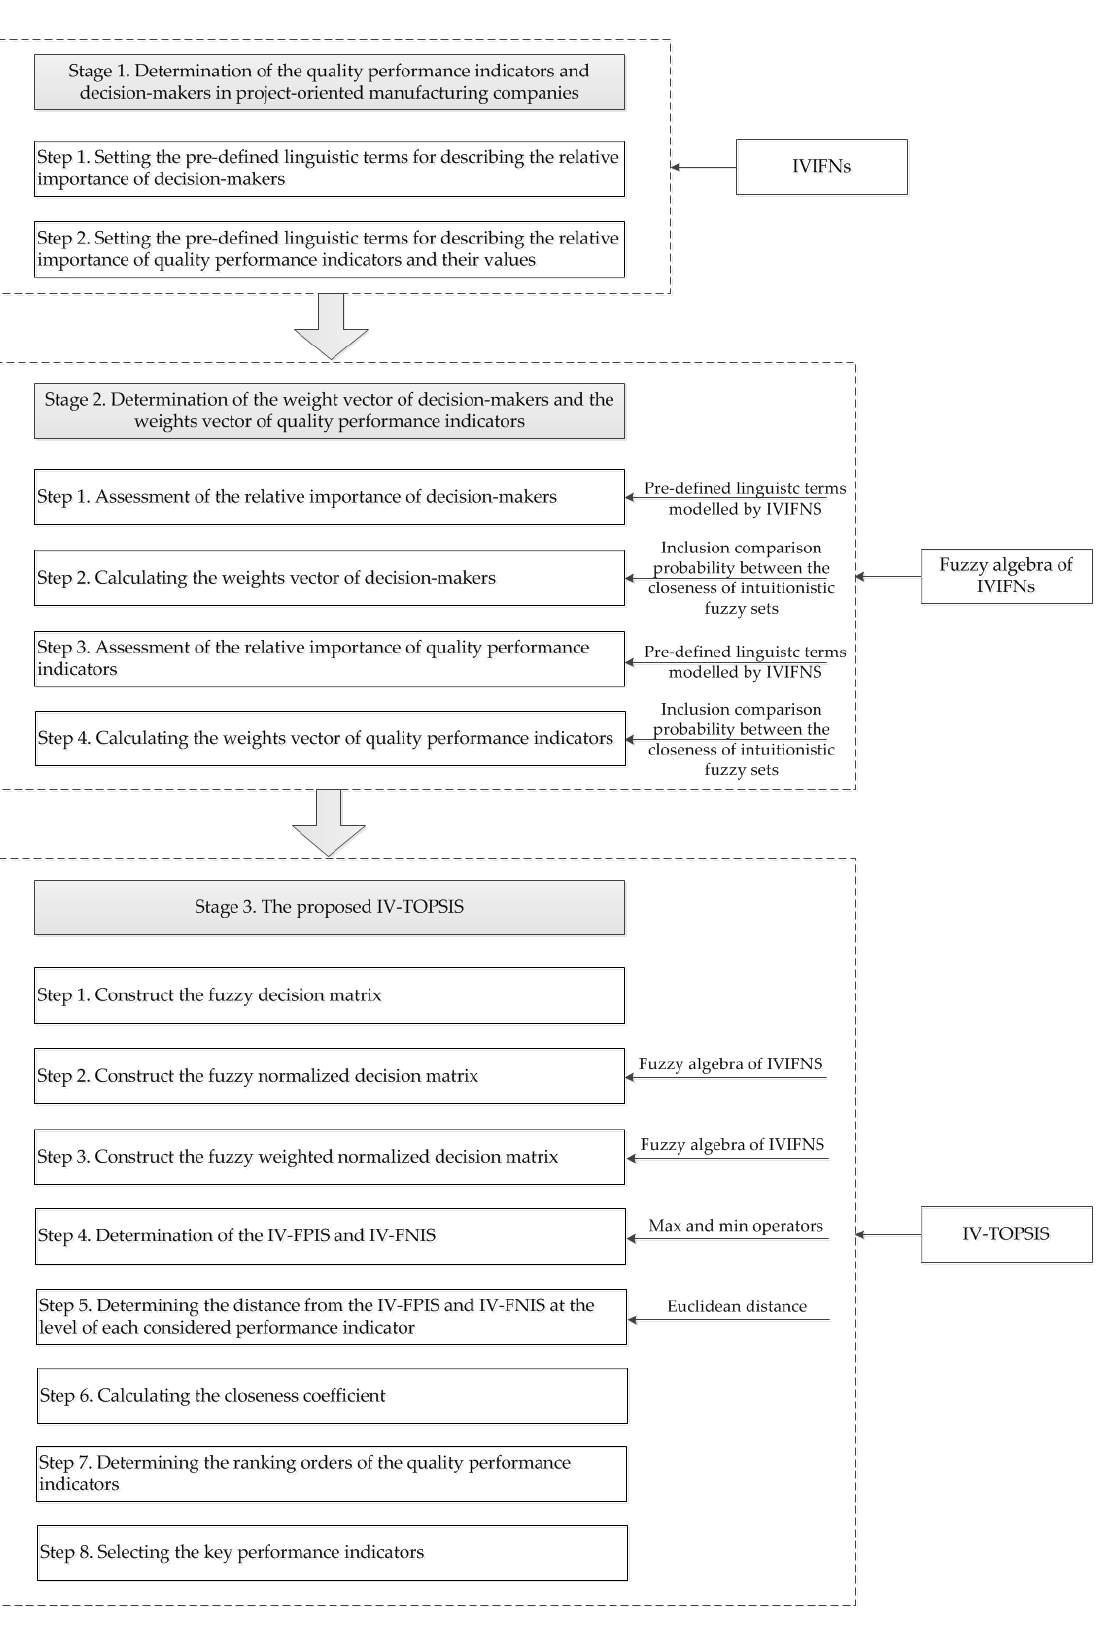
Figure 1. The proposed model.